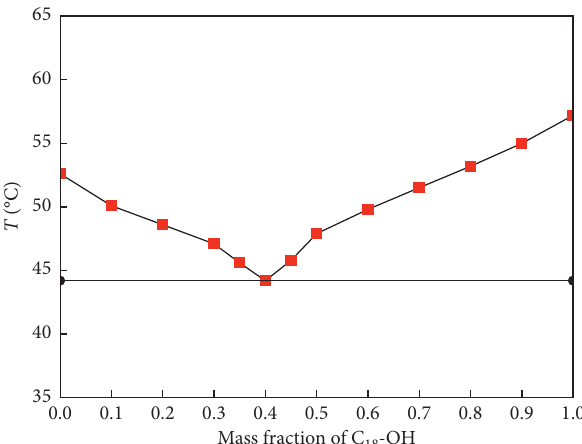
Figure 2: Phase diagram of the binary system (C 18 -OH+C 18 -acid). Table 3: Comparison of the melting temperature (from the second heating scan) between the experimental and calculated values a . Temperature, T p ( ° C) Mass fraction (C 18 -OH) (%) Experiment value